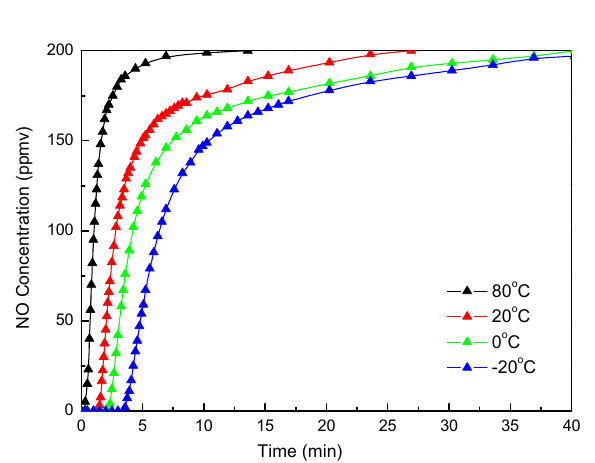
Figure 6. Breakthrough curve of NO adsorption at 80, 20, 0 and − 20 ℃ (NO = 200 ppmv, space velocity = 5000 h −1 ).